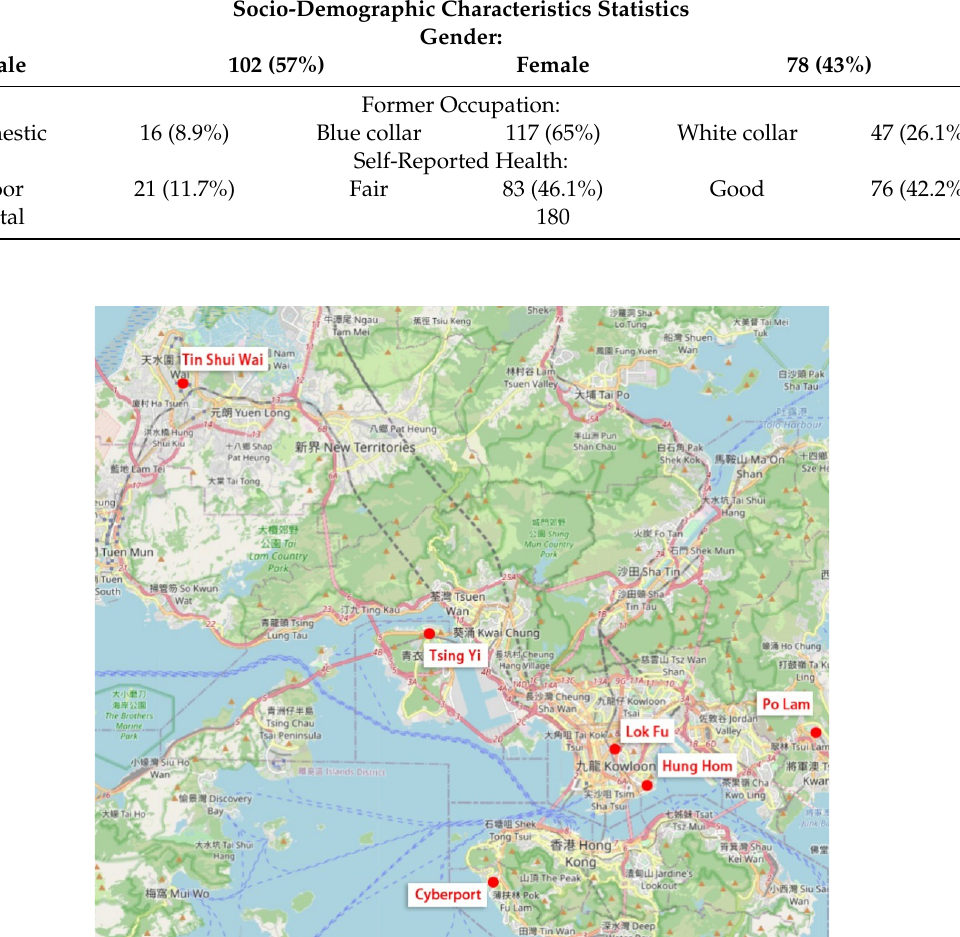
Figure 1. Distribution of the chosen regions in Hong Kong.